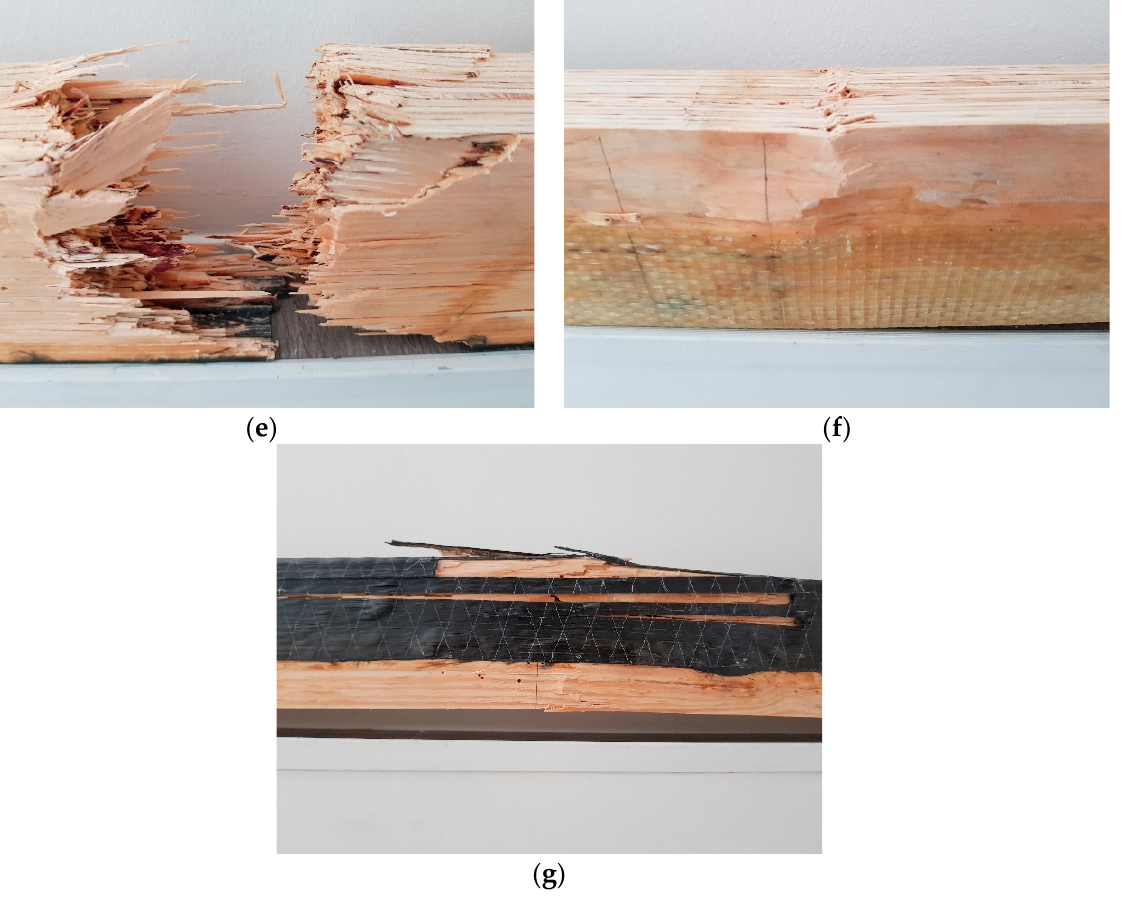
Figure 9. Failure modes: ( a ) brittle fracture in tension zone; ( b ) tensile failure of composite sheet and LVL; ( c ) tensile failure of LVL; ( d ) shear failure of LVL; ( e ) splitting failure—extensive rupture; ( f ) compressive failure of LVL; ( g ) compressive failure of LVL and tensile failure of LVL and composite.